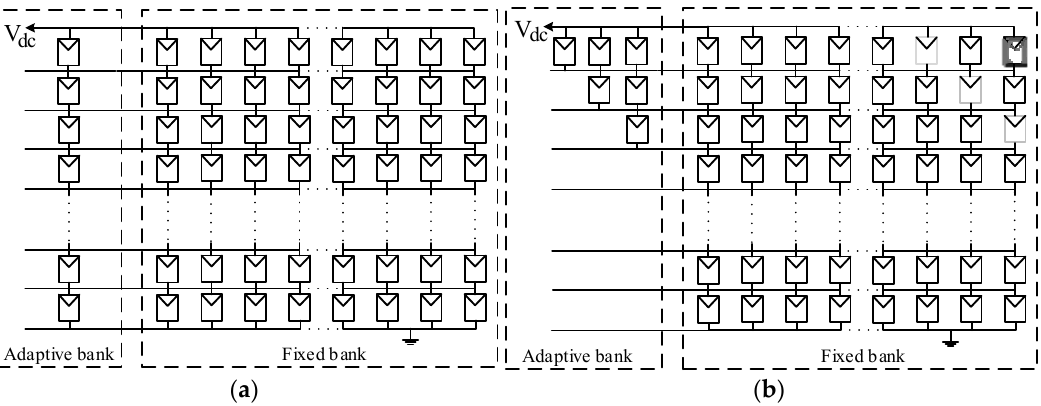
Figure 6. Dynamic PV Array: during uniform insolation conditions ( a ); reconfigured to compensate for partial shading ( b ) [21].